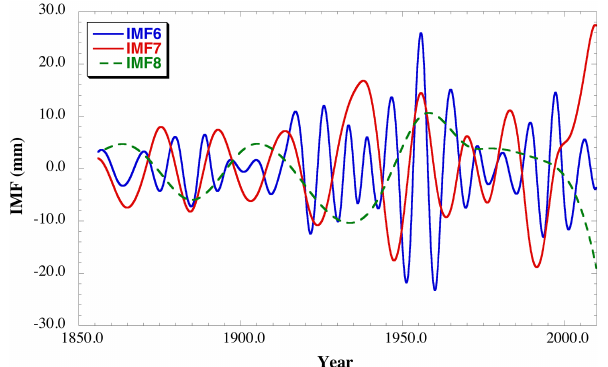
Figure 7. Low-frequency IMFs resulting from EMD of a simulated signal with a trend + acceleration + seasonal variations + random noise + a single large anomalous event in January